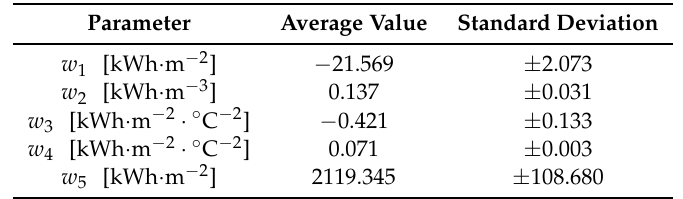
Figure 4. ( a ) Distribution of the mean absolute percent error (MAPE) between the PVGIS and the predicted values of H y , for the 10,000 repetitions of the training/validation process for the coefficients of Equation (1). Red lines refer to the cumulative distribution functions of the MAPE values. ( b ) Distribution of H y for the 80 considered locations in Europe and Africa: comparison between PVGIS data (black dots) and estimations by Equation (1) with the optimal coefficients in Table 1 (red triangles). Note that the maximum average yearly sum of global solar irradiation is found at the Tropic of Cancer and Capricorn ( ± 23 ◦ latitude). In the inset, the cumulative distribution function of the percent estimation errors is shown. Table 1. Model coefficients of Equation (1) obtained by the (training/validation) fitting procedure on the data sets in Tables A1 and A2. The standard deviation indicates the variability of the fitted coefficients in the 10,000 different training sets. Note that, in Equation (1), the latitude is intended in decimal